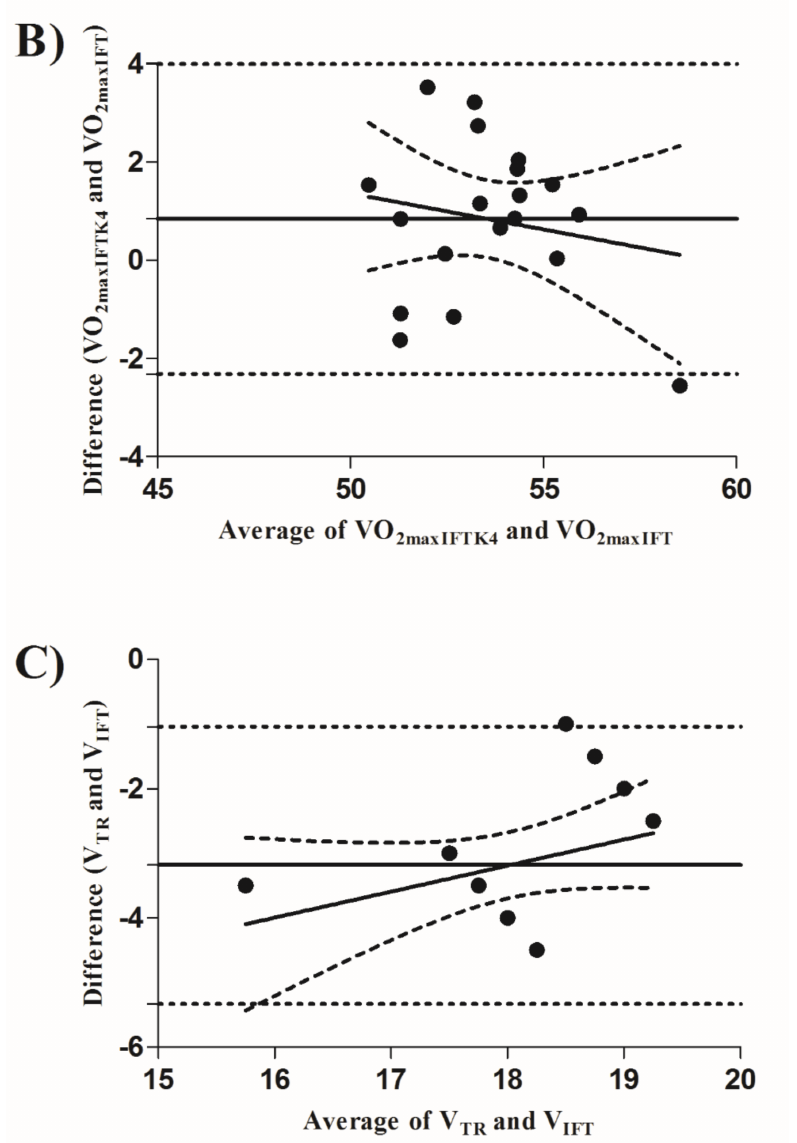
Figure 2. Bland–Altman plots comparing VO 2maxTR and VO 2maxIFTK4 ( A ); VO 2maxIFTK4 and VO 2maxIFT ( B ); V TR and V IFT ( C